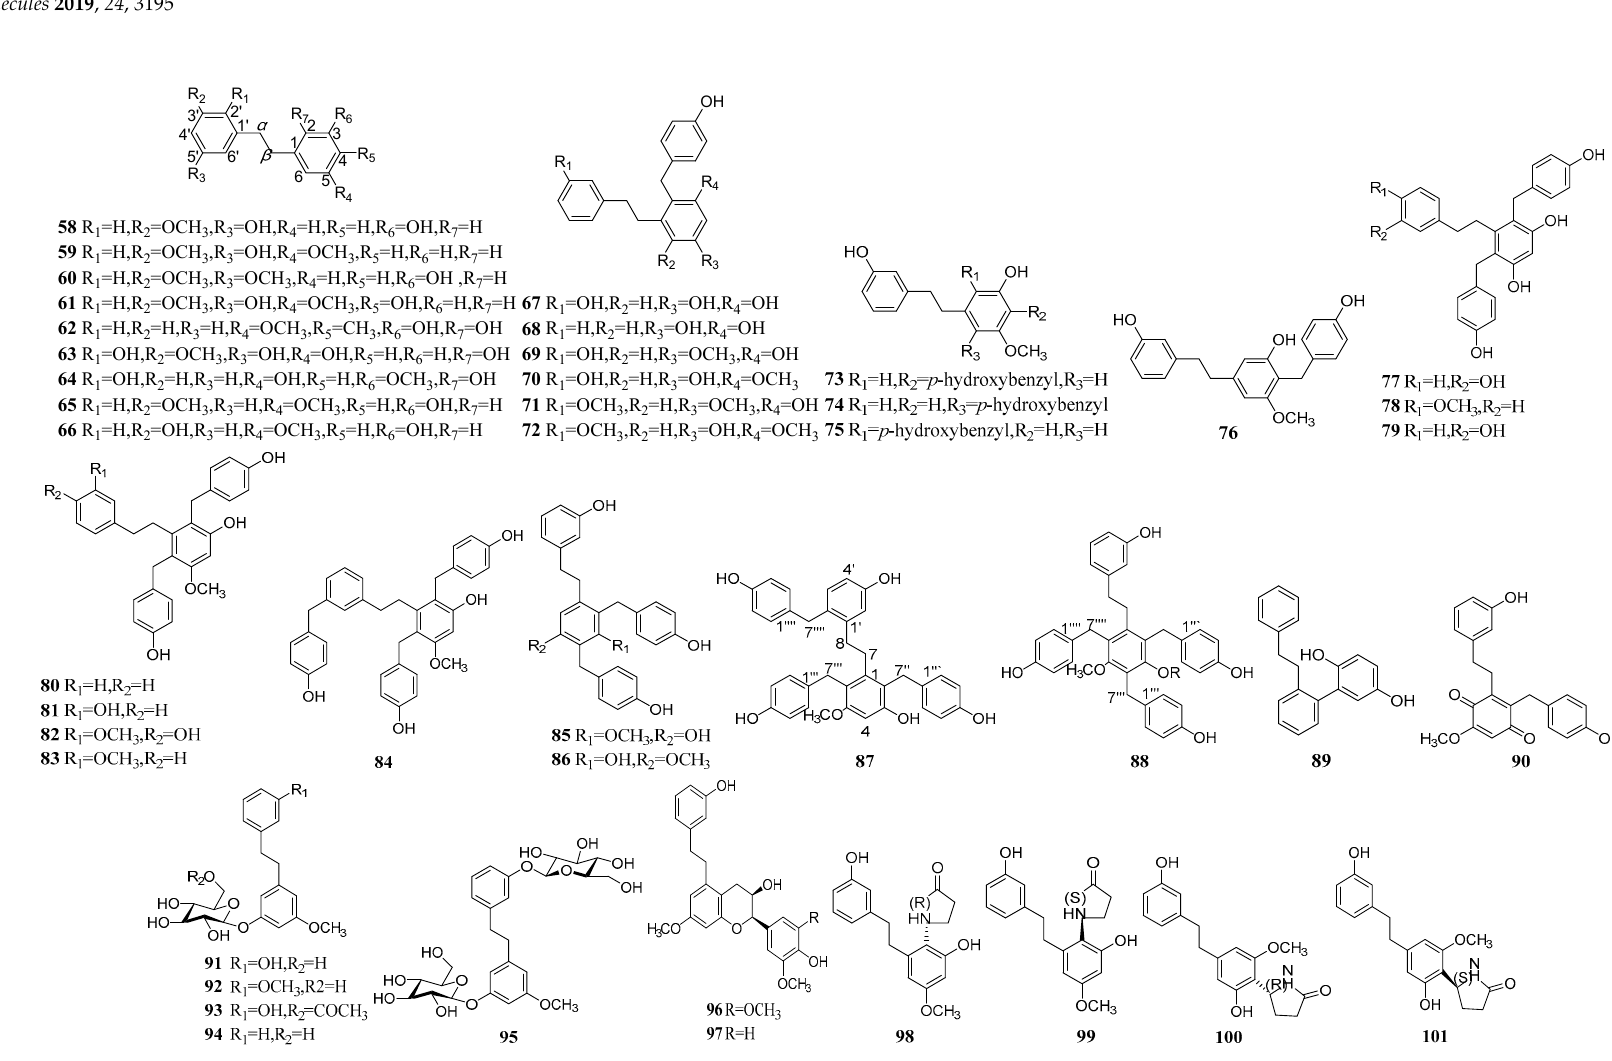
Figure 2. The structures of Bibenzyls.